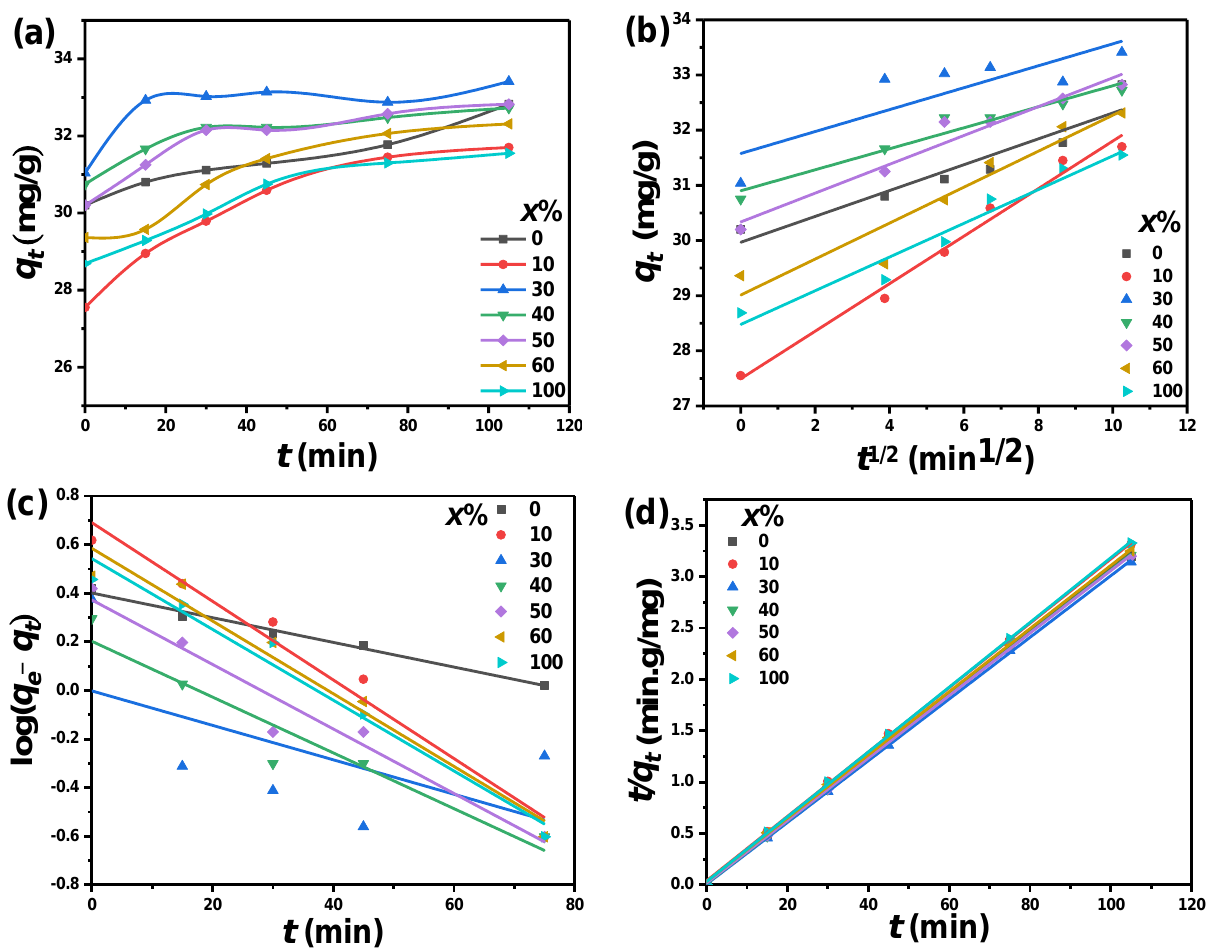
Figure 8. ( a ) Adsorption capacity ( q t ) of MB, ( b ) intra-particle diffusion model, ( c ) pseudo-first- order kinetic model, and ( d ) pseudo-second-order kinetic model for the adsorption of MB using PbO- x %Al 2 O 3 composites as a